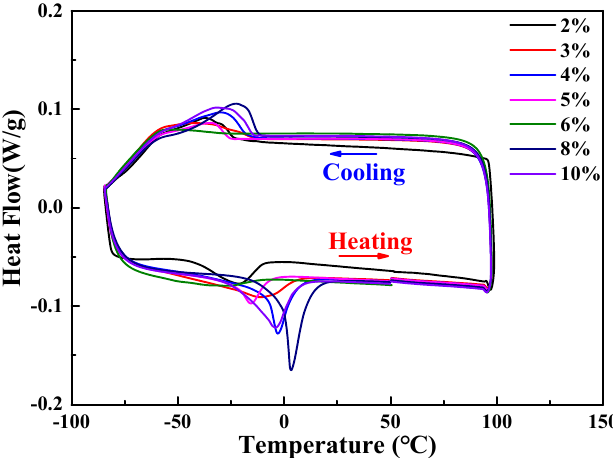
Figure 11. DSC measurements after different cryogenic pre-deformations.